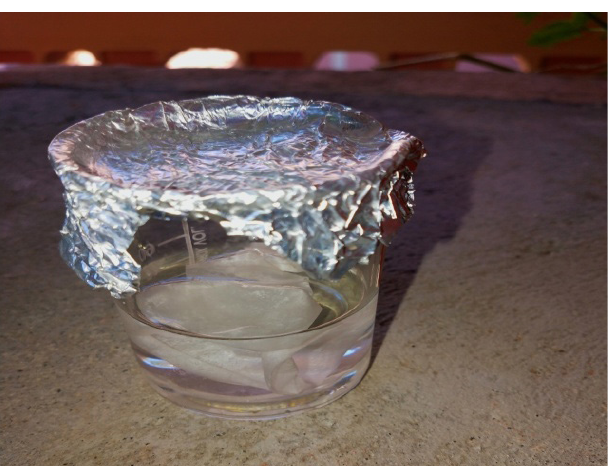
FIGURE 3 - Membrane in